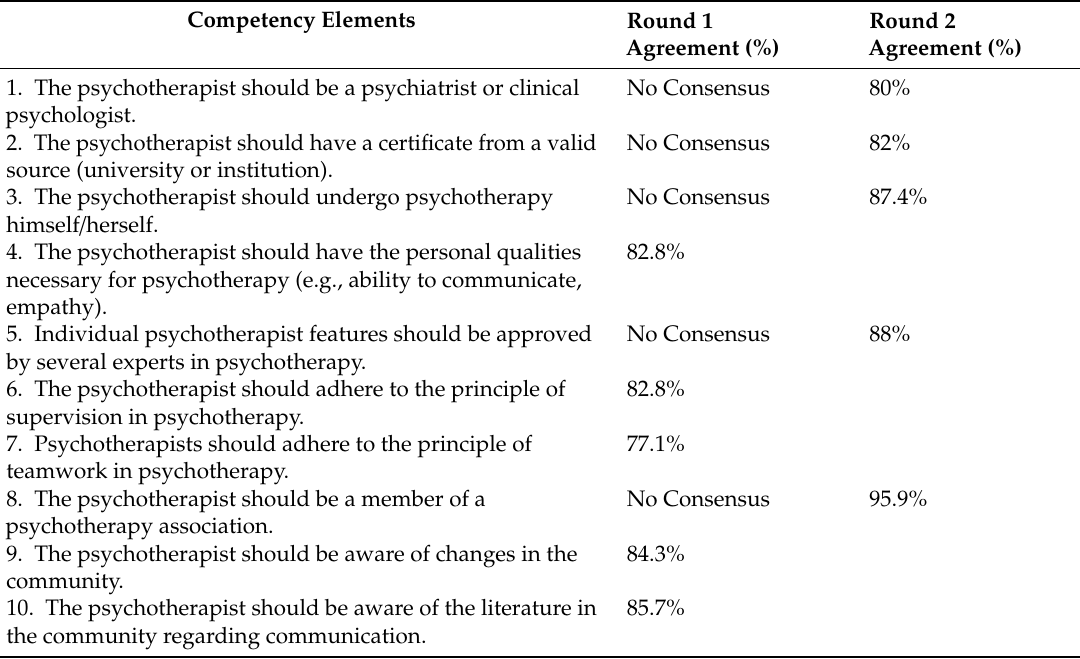
Table 3. Results of rounds 1 and 2 for psychotherapist